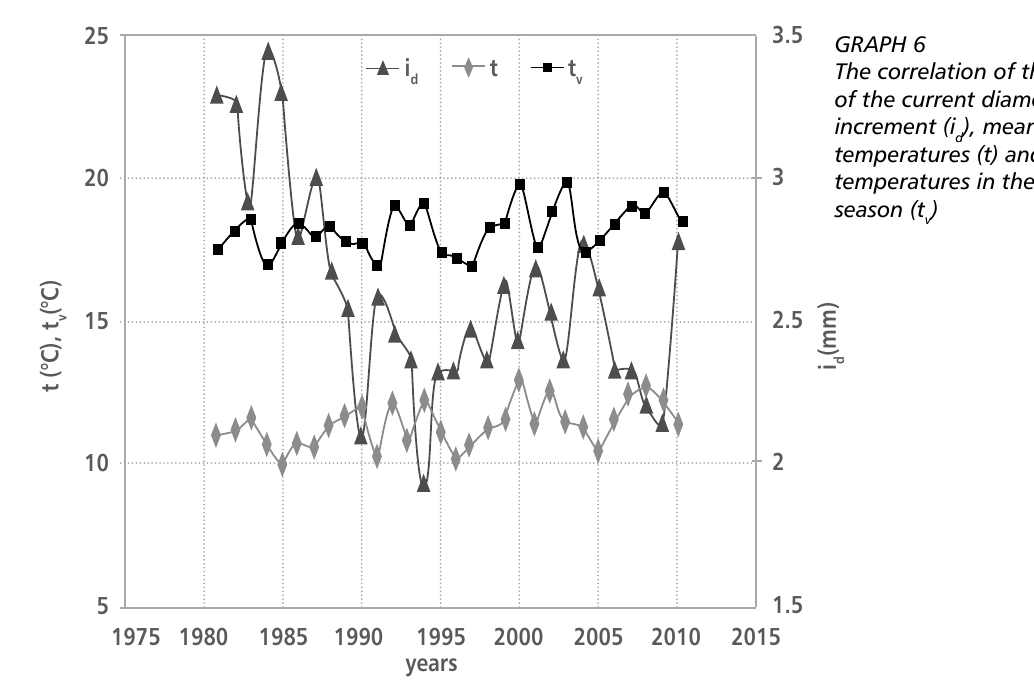
sum of precipitation and precipitation in the vegeta - tion period per years of the observed period. With in - creasing of amounts of precipitation during the year, especially in the growing season, the diameter incre - ment increases, and vice